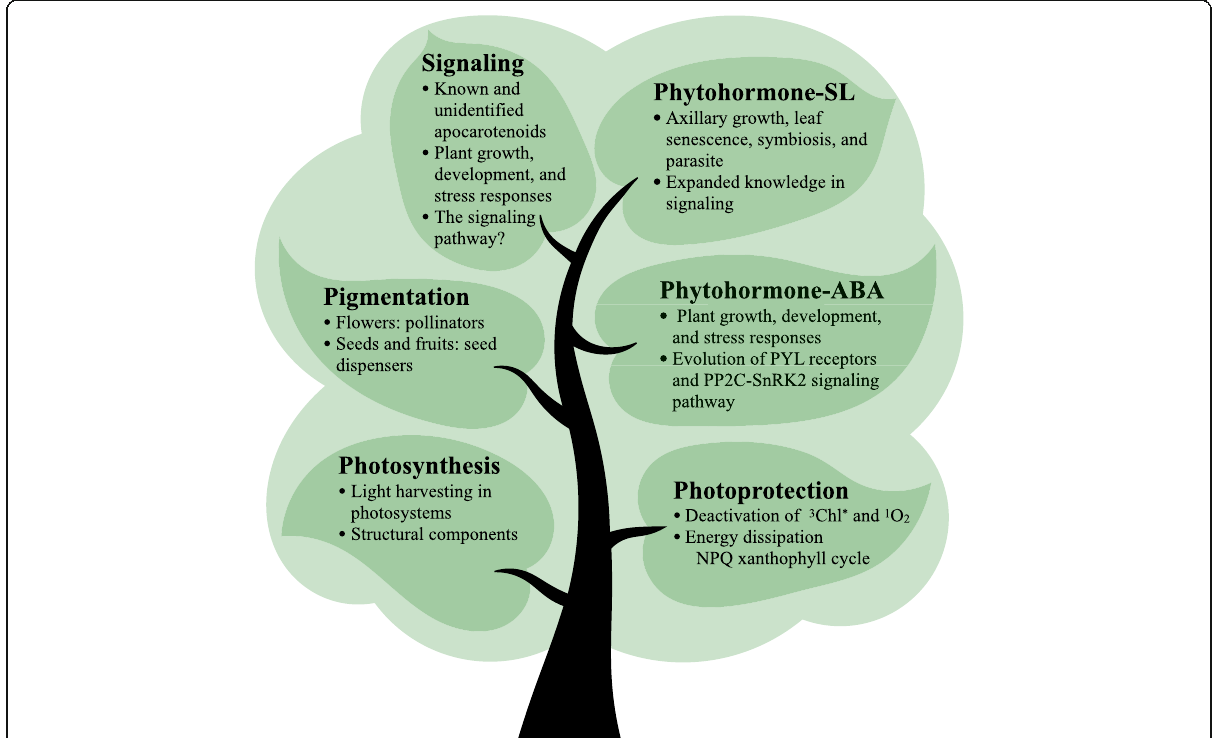
Fig. 4 Basic and acquired functions of carotenoids during plant evolution. Carotenoids play central roles in photosynthesis and photoprotection as the key components of photosystems. Carotenoids also contribute to the pigmentation of seeds, fruits, and flowers, which showed co- evolution with seed dispensers and pollinators. Carotenoid derived phytohormone, including abscisic acid (ABA) and strigolactone (SL), arise from the evolution of land plants. Apocarotenoid signaling affects plant growth, development, and stress response, but more signaling molecules